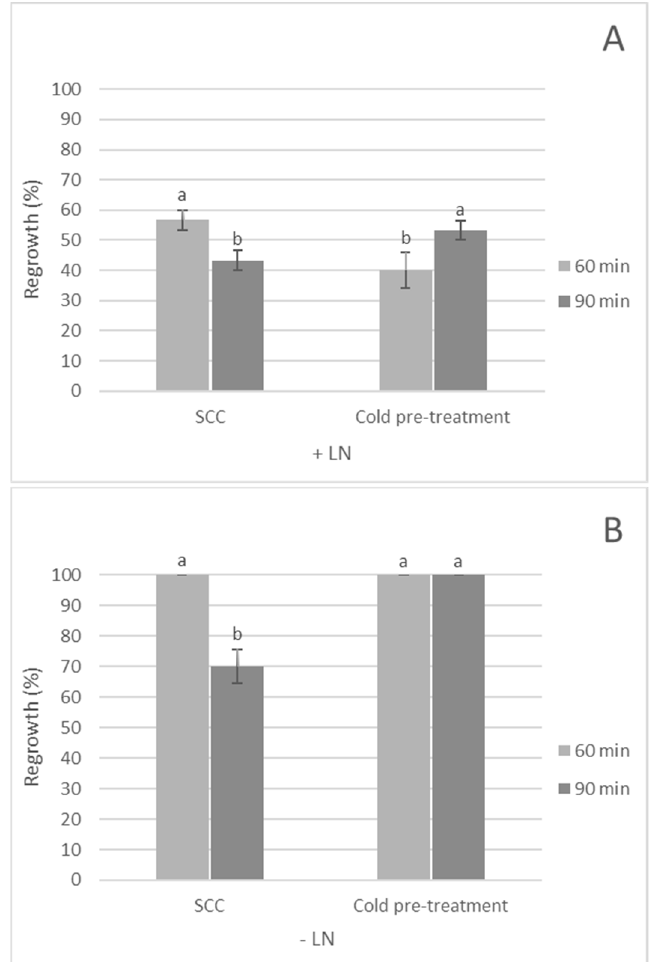
Figure 4. Effect of cold pre-treatment (4 °C) of mother plant’s on regrowth (%) of axillary buds immersed in PVS3 (60 or 90 min) with ( A ) or without ( B ) liquid nitrogen (LN) immersion. SCC— standard cultural conditions. Error bars indicate SE. Bars of means marked with the same letter are not significantly different according to Tukey’s test ( p ≤ 0.05).